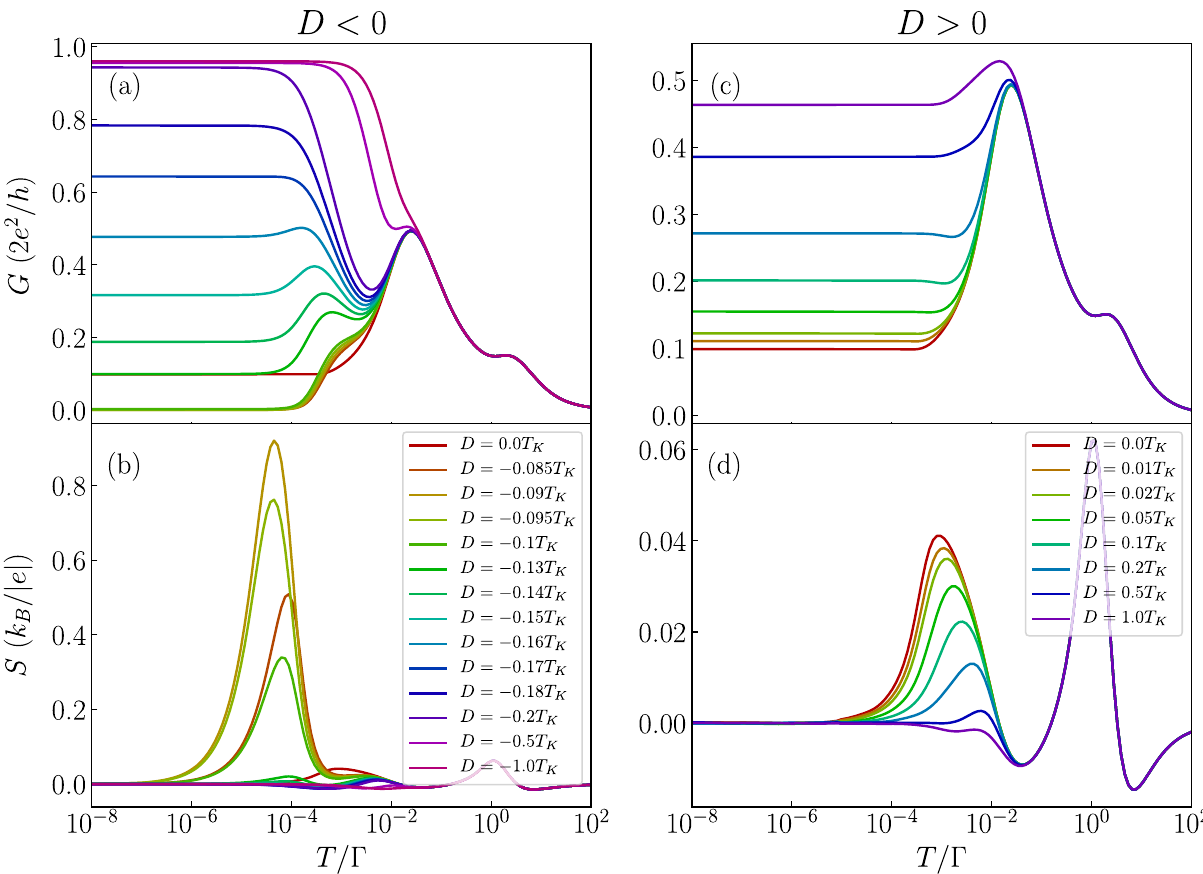
Figure 7. The effects of magnetic anisotropy in the case of ferromagnetic junction. The temperature dependence of ( a , c ) the conductance and ( b , d ) the Seebeck coefficient in the case of antiferromagnetic exchange interaction J = − T K for selected values of magnetic anisotropy D . The left (right) column presents the case of easy-plane (easy-axis) type of magnetic anisotropy. The parameters are the same as in Fig. 5 with ε = − 0.48 U